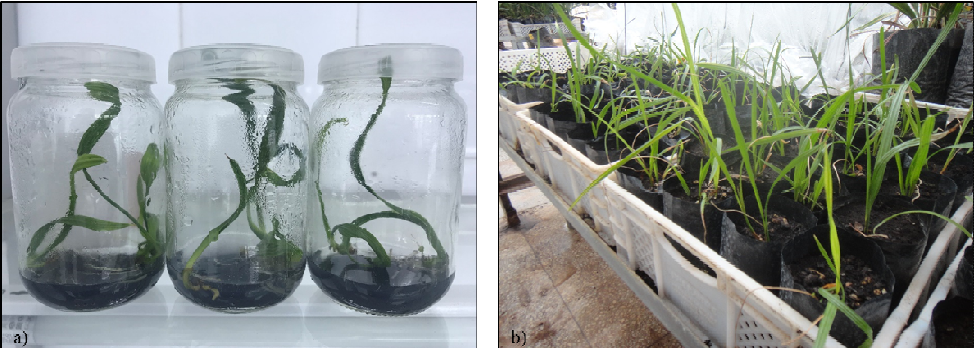
Fig. 2. Plantlet regeneration and acclimatization. a Plantlets obtained after 5 months of culture on PGR-free MS medium. b Plantlet survival after 6 months in the